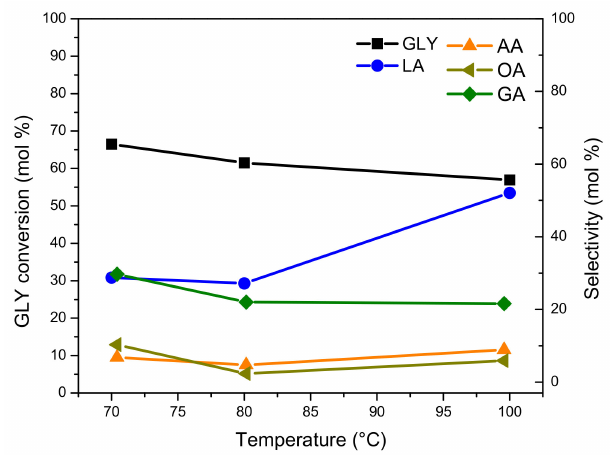
Figure 8. GLY conversion and oxidation products’ selectivity vs. reaction temperature in GLY oxidation of the Pt-ZSM-11